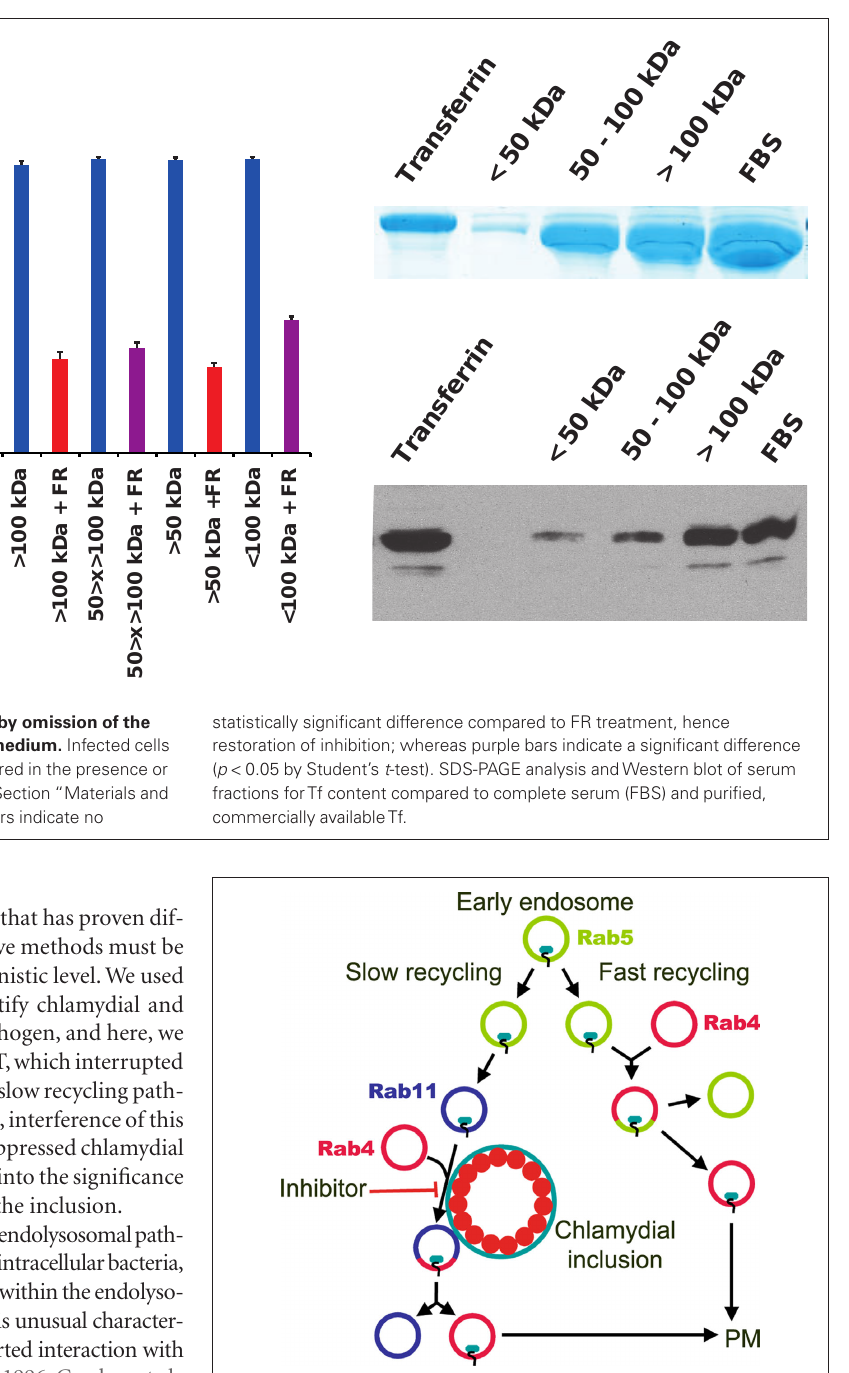
Figure 9 | A model for the action of Fr179254 against chlamydiae. Transferrin is recycled through two main pathways. For fast recycling, the majority of transferrin ( ∼ 80%) is endocytosed into a Rab5 positive early endosome, which subsequently fuses with Rab4 recycling endosomes for transport back to the plasma membrane (PM) in Rab4 vesicles. For slow recycling, transferrin ( ∼ 20%) is endocytosed into Rab5 early endosomes, which mature to Rab11 compartments that then fuse with Rab4 for recycling back to the PM. FR179254 delays the fusion of transferrin-containing Rab11 vesicles with Rab4 recycling vesicles, possibly at the inclusion membrane, leading to chlamydial growth